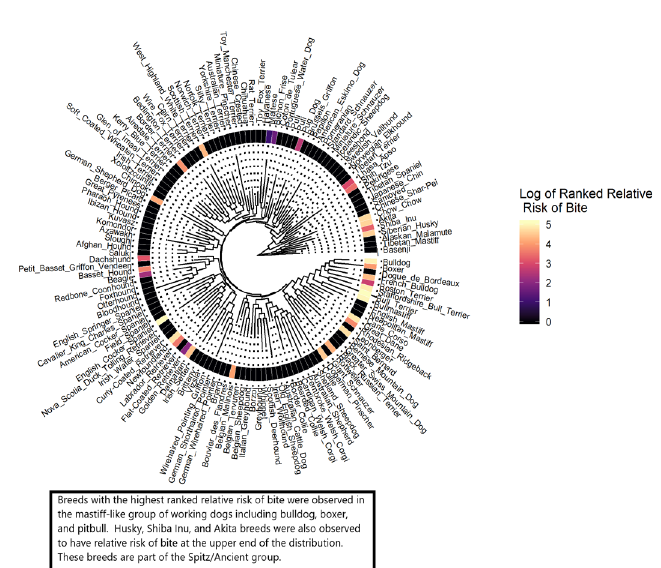
Figure 8. Phylogenetic tree of dog breeds associated with risk for dog bite within the